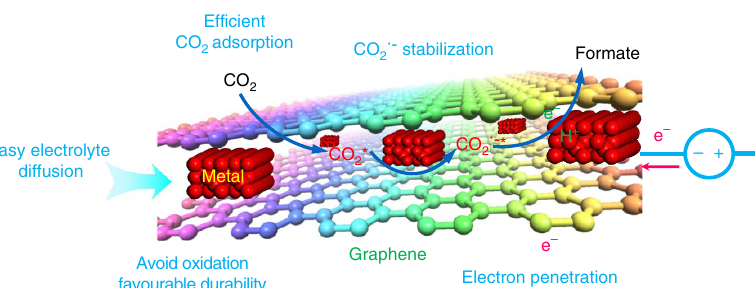
Figure 1 | Scheme. Schematic illustration depicts the several advantages of ultrathin metal layers confined in graphene for CO 2 electroreduction into hydrocarbon